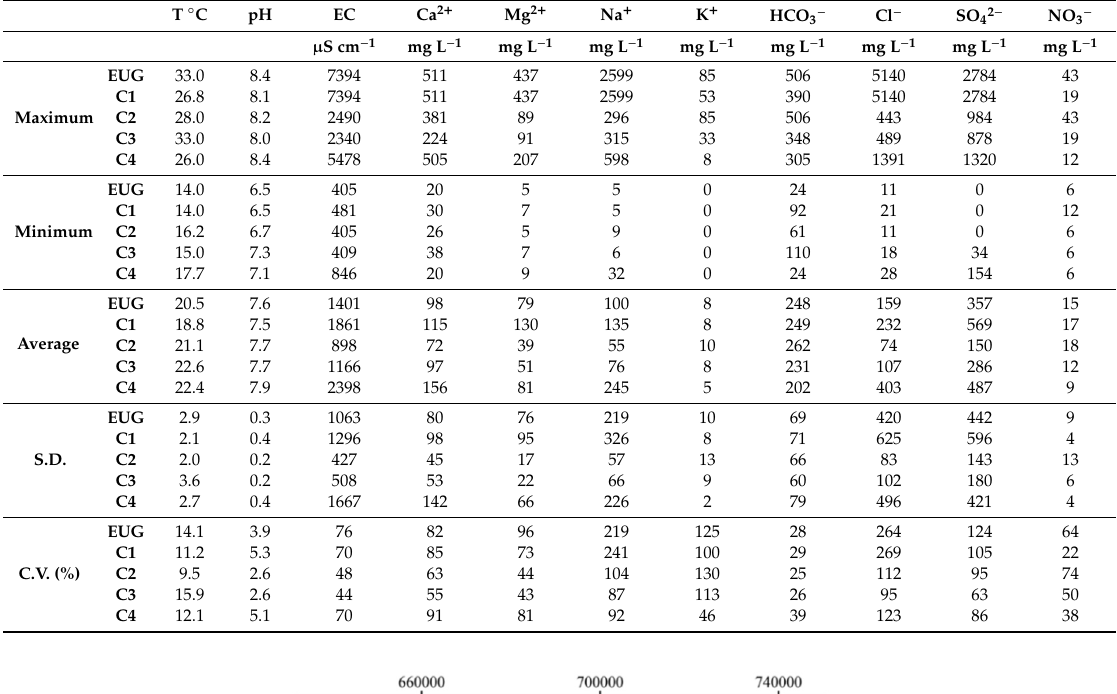
Table 2. Descriptive statistics of the hydrochemical data. EUG: Eastern Upper Guir; C1–C4: sub-basins; EC: electrical conductivity; SD: standard deviation; CV: coe ffi cient of variation.